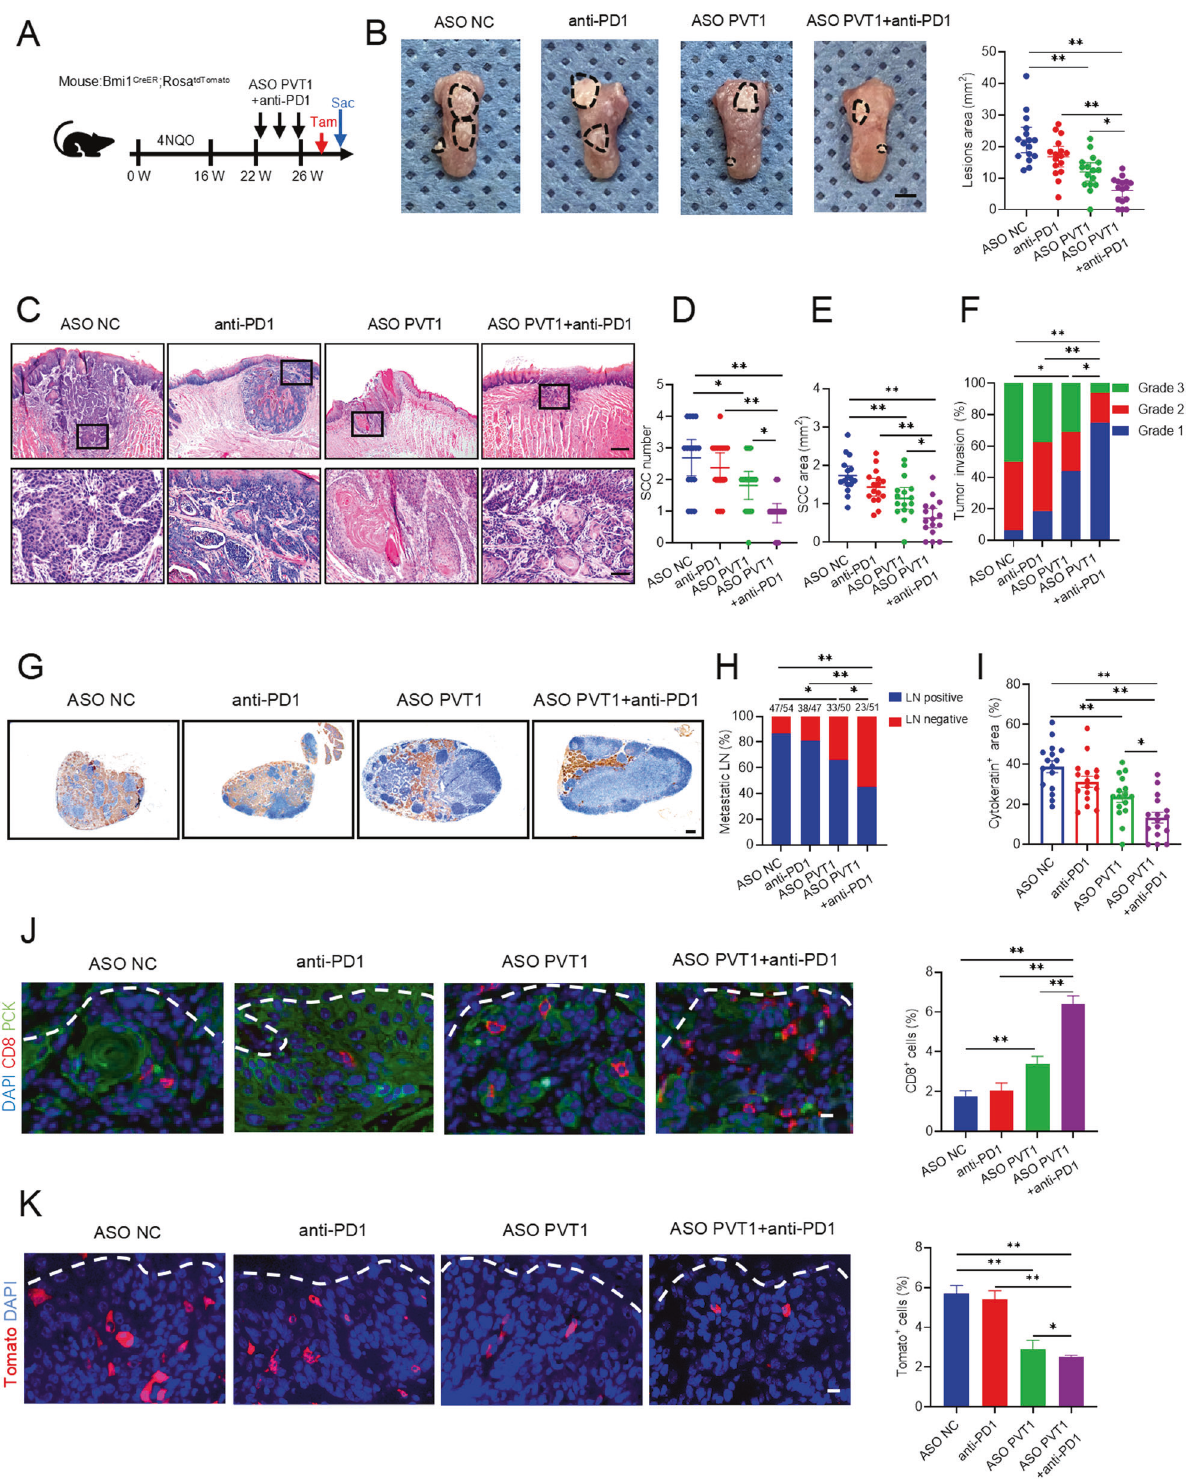
cancer immunotherapies [47]. Our study assessed the extent of DNA damage through pH2A.X and comet assays to explore the role of PVT1 in DNA damage. We determined that PVT1 was associated with DNA damage in HNSCC. Our data showed PVT1 KD triggered DNA damage accumulation; mediated the expres- sion and secretion of proin fl ammatory cytokines and proin fl am- matory chemokines (CXCL9, CXCL10, CXCL11); and activated CD8